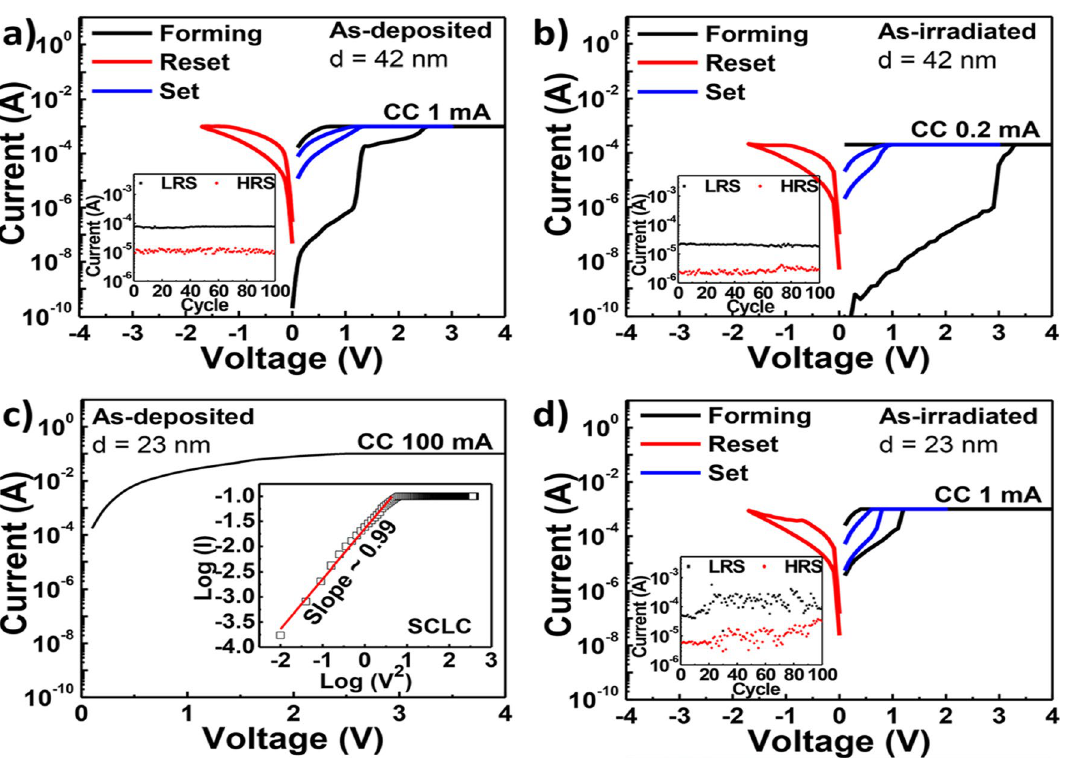
Fig. 17 Characteristics I–V curves of Cu/ZnO/ITO device structure showing as per-deposited and as per-irradiated devices with 42- and 23-nm ZnO RS layer thickness. a and b The insets of the as per-deposited and as per-irradiated 42-nm-thick ZnO-based devices, respectively. c and d The insets of the as per-deposited and as per-irradiated 23-nm-thick ZnO-based devices, respectively. The insets illustrate the signifi- cance of the oxidation process to the RS layer of the ZnO